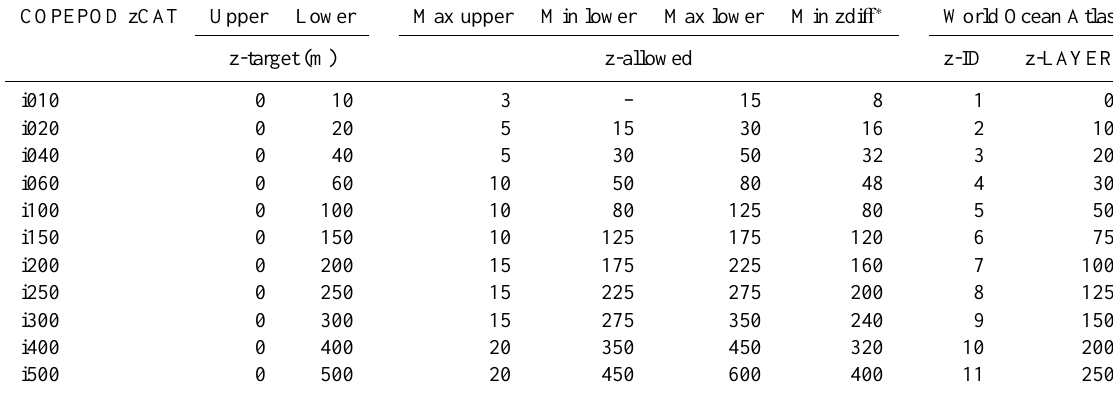
Table 4. Description of COPEPOD depth interval criteria and World Ocean Atlas equivalents. COPEPOD zCAT